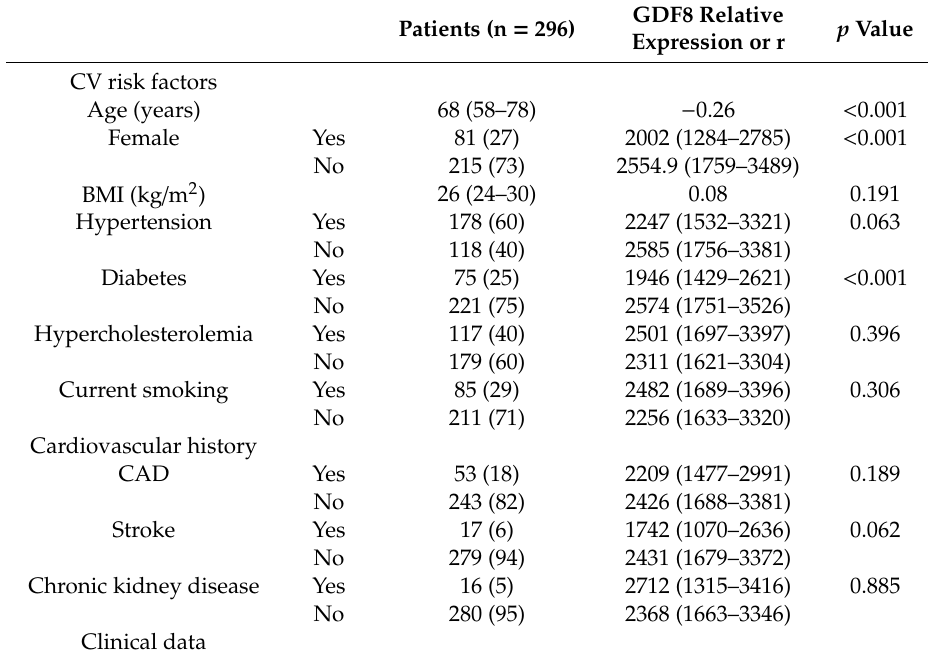
Table 2. Association between GDF8 levels and study variables ( n =